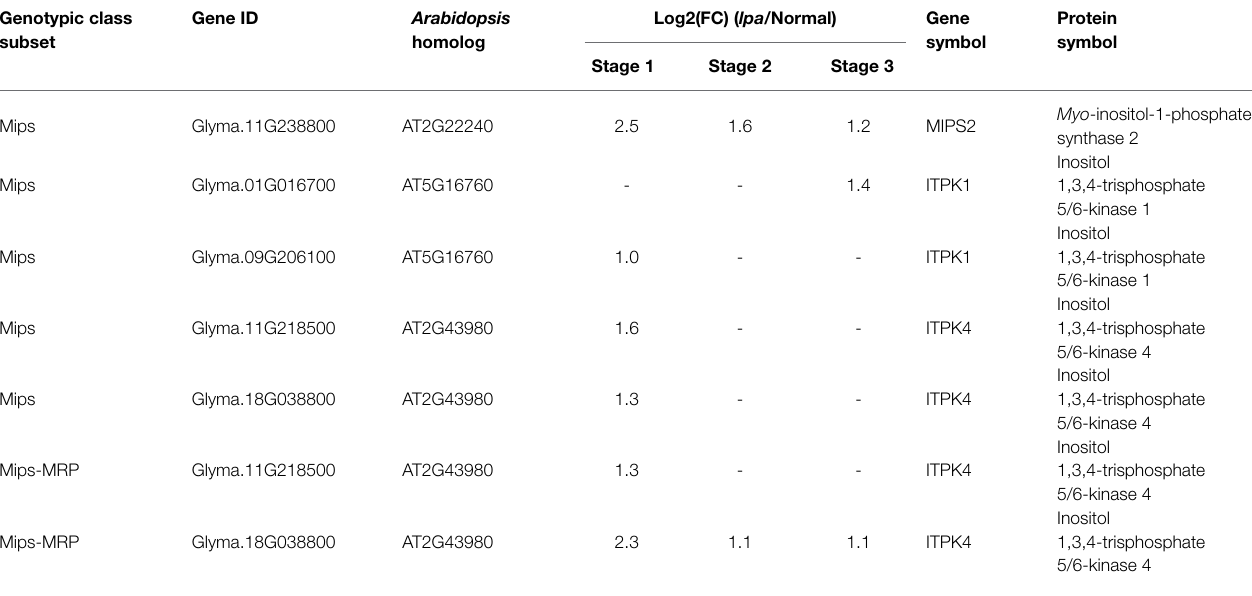
TABLE 2 | DEGs in the phytic acid biosynthesis pathways. Genotypic class